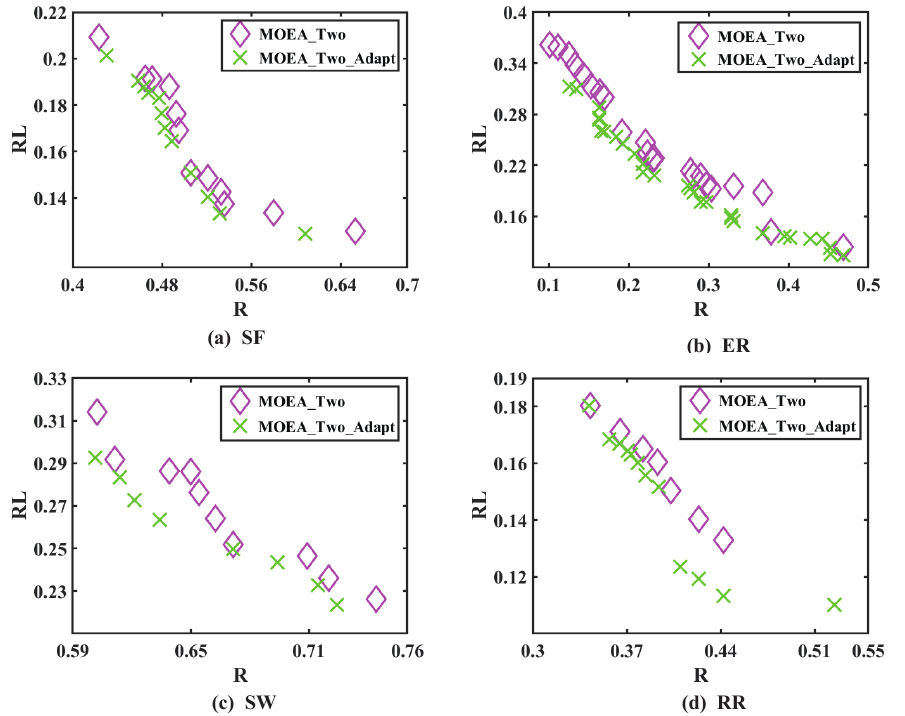
Figure 5. MOEA_Two and MOEA_Two_Adapt under four types of complex network.